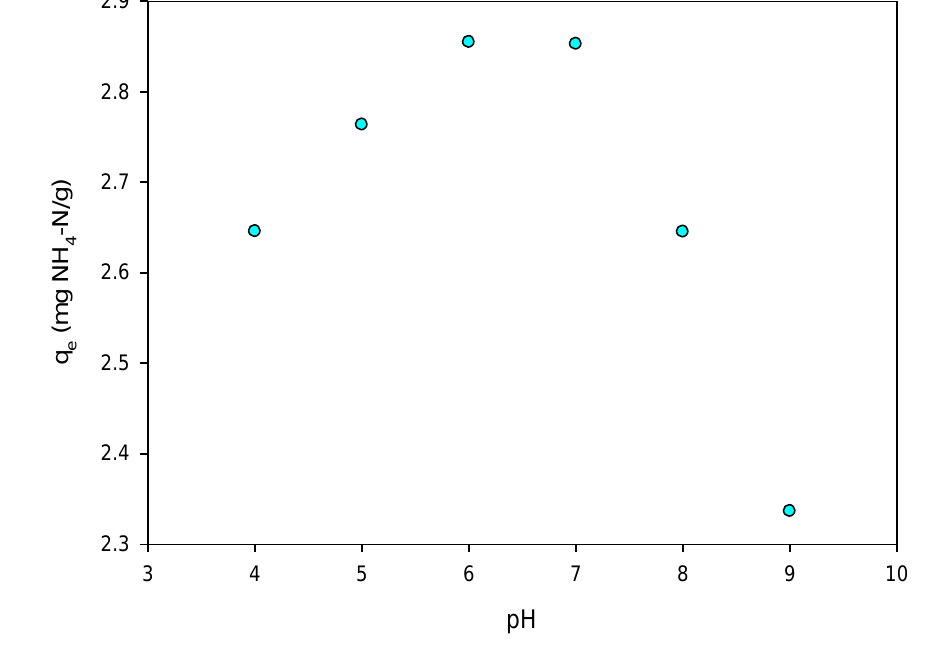
Figure 7. Behavior of the q e as a function of pH .